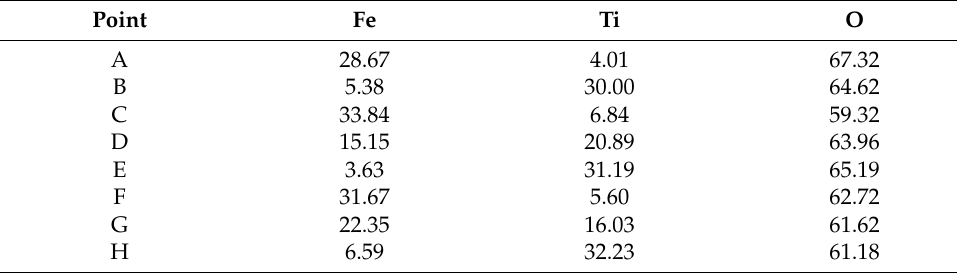
Figure 10. Schematic diagram of microstructure transition of oxidation roasting ilmenite above 800 ◦ C. ( a ) initial oxidation product, ( b ) formation of Fe 2 Ti 3 O 9 , ( c ) decomposition of Fe 2 Ti 3 O 9 and ( d ) final oxidation product. Table 2. Atomic percentage of points in Figure